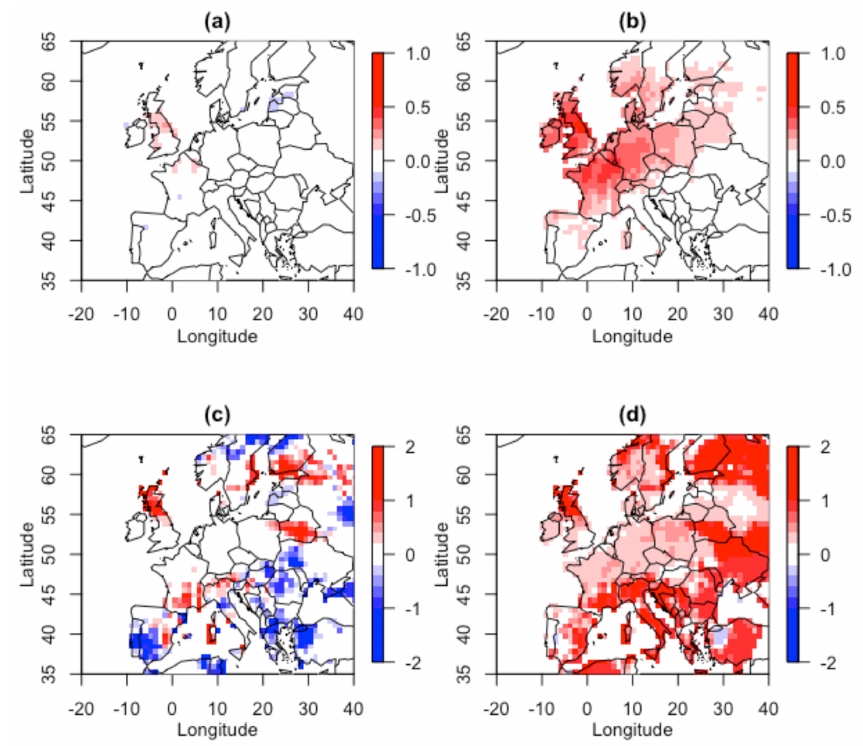
Figure 7. The difference between empirical and modelled χ( 0 . 01 ) for (a) the Gaussian model and (b) the Gumbel model, and the difference between empirical and modelled χ (0.01) for (c) the Gaussian model and (d) the Gumbel model, for London paired with all other locations over